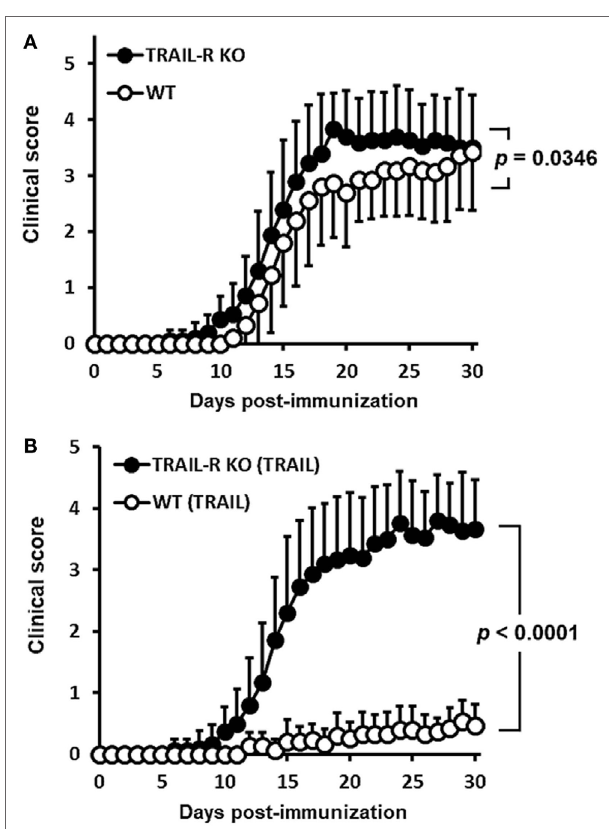
FigUre 2 | TRAIL-mediated inhibition of neuroinflammation in experimental autoimmune encephalomyelitis is through TRAIL-R. (a) Wild-type (WT) and TRAIL receptor-knockout (TRAIL-R KO) mice were immunized with the myelin oligodendrocyte glycoprotein (MOG) 35–55 peptide (200 µg/mouse, s.c.) in a complete Freund’s adjuvant (CFA) emulsion on day 0 followed by pertussis toxin (250 ng/mouse, i.p.) on days 0 and 1. Clinical scores among groups were measured at the indicated time points ( n = 15 in each group). Statistics were calculated by the two way ANOVA. (B) WT and TRAIL-R KO mice were immunized with the MOG 35–55 peptide (200 µg/mouse, s.c.) in a CFA emulsion on day 0 followed by pertussis toxin (250 ng/mouse, i.p.) on days 0 and 1. Beginning on day 2 after immunization, mice were treated daily with TRAIL (100 µg/mouse, i.p.). Clinical scores among groups were measured at the indicated time points ( n = 15 in each group). Statistics were calculated by the two way ANOVA.